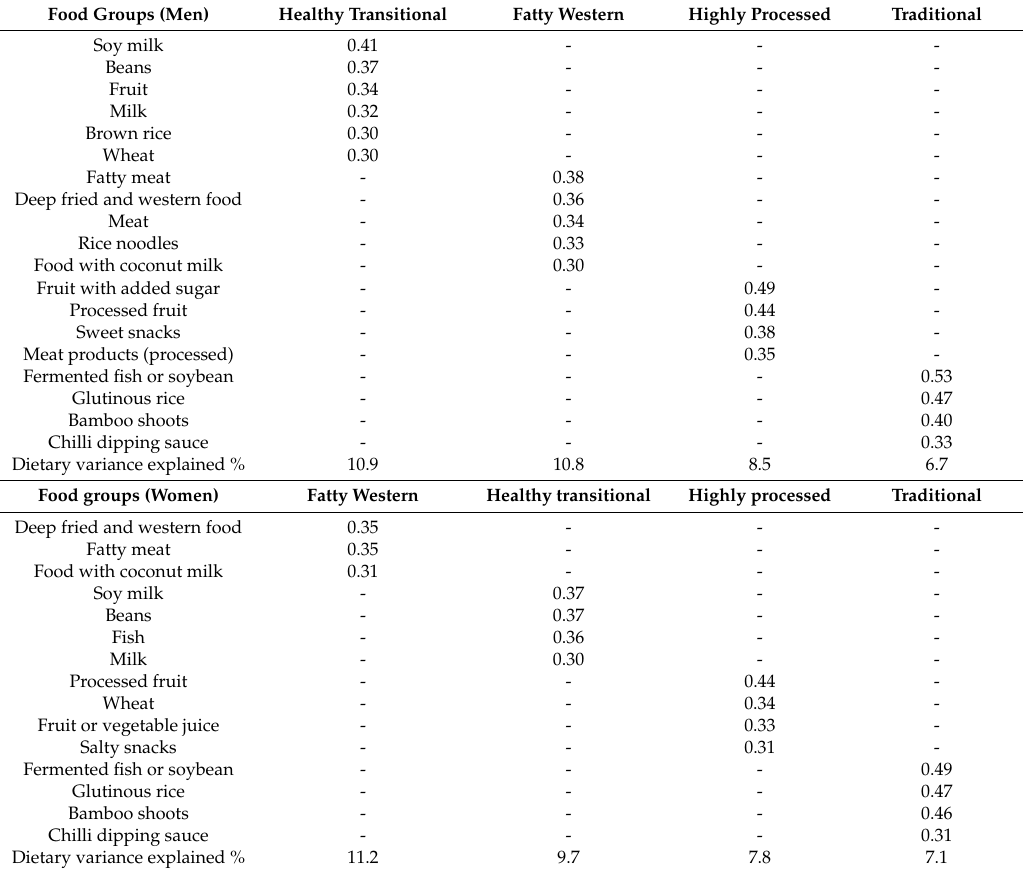
Table 1. Factor loadings * for four dietary patterns identified among Thai